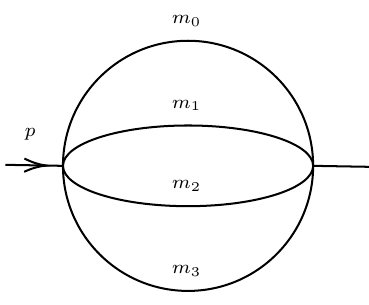
Figure 6 . The three-loop unequal mass sunrise